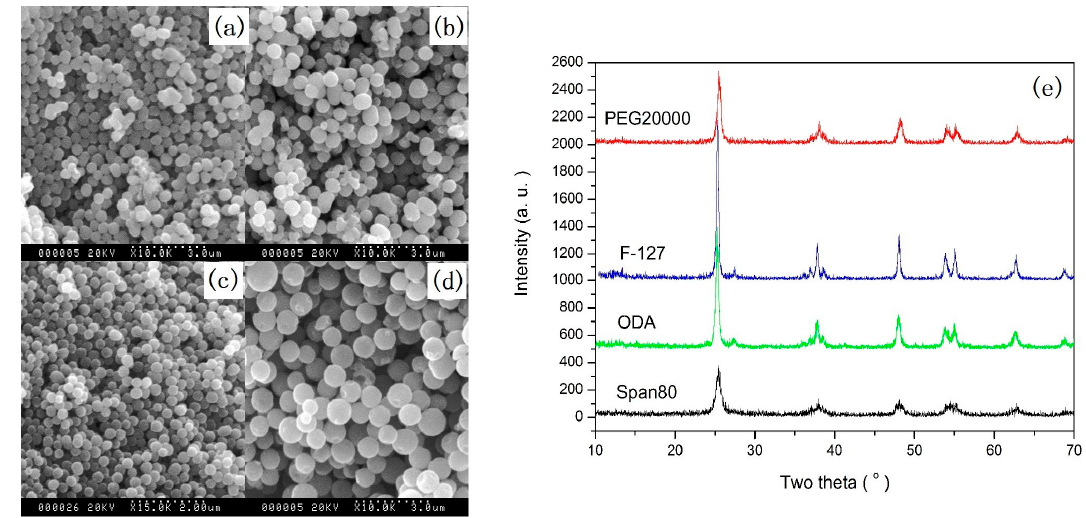
Figure 1. SEM (Scanning electron microscopy) images (( a ) PEG (polyethylene glycol) 20000, ( b ) ODA (octadecylamine), ( c ) F-127, ( d ) Span80) and the XRD (X-ray diffraction) patterns ( e ) of TiO 2 spheres synthesized by adding different polymers [37].